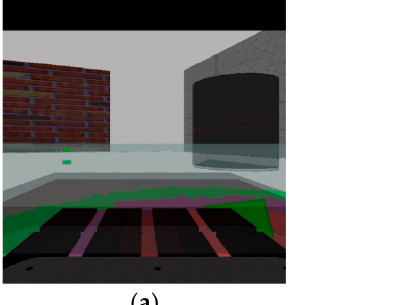
Figure 11. Real-time radiation-detection results in simulation: ( a ) camera view and ( b ) local radiation map.